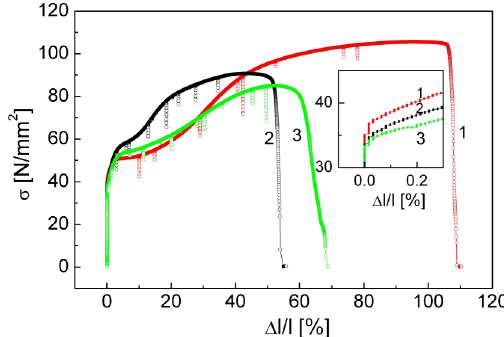
FIG. 7. Tensile tests results for three LG samples cut according to Fig.